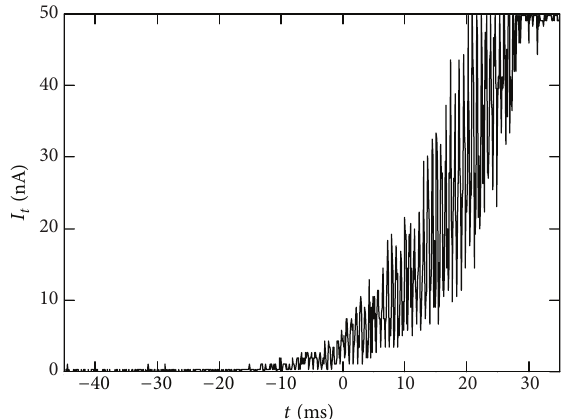
Figure 3: Typical probe current waveform 𝐼 𝑡 (𝑡) measured during the recording of 𝐼 - 𝑉 curve of AFM probe contact to the YSZ/Si film surface at the linear sweep of 𝑉 𝑔 in time from 0V to